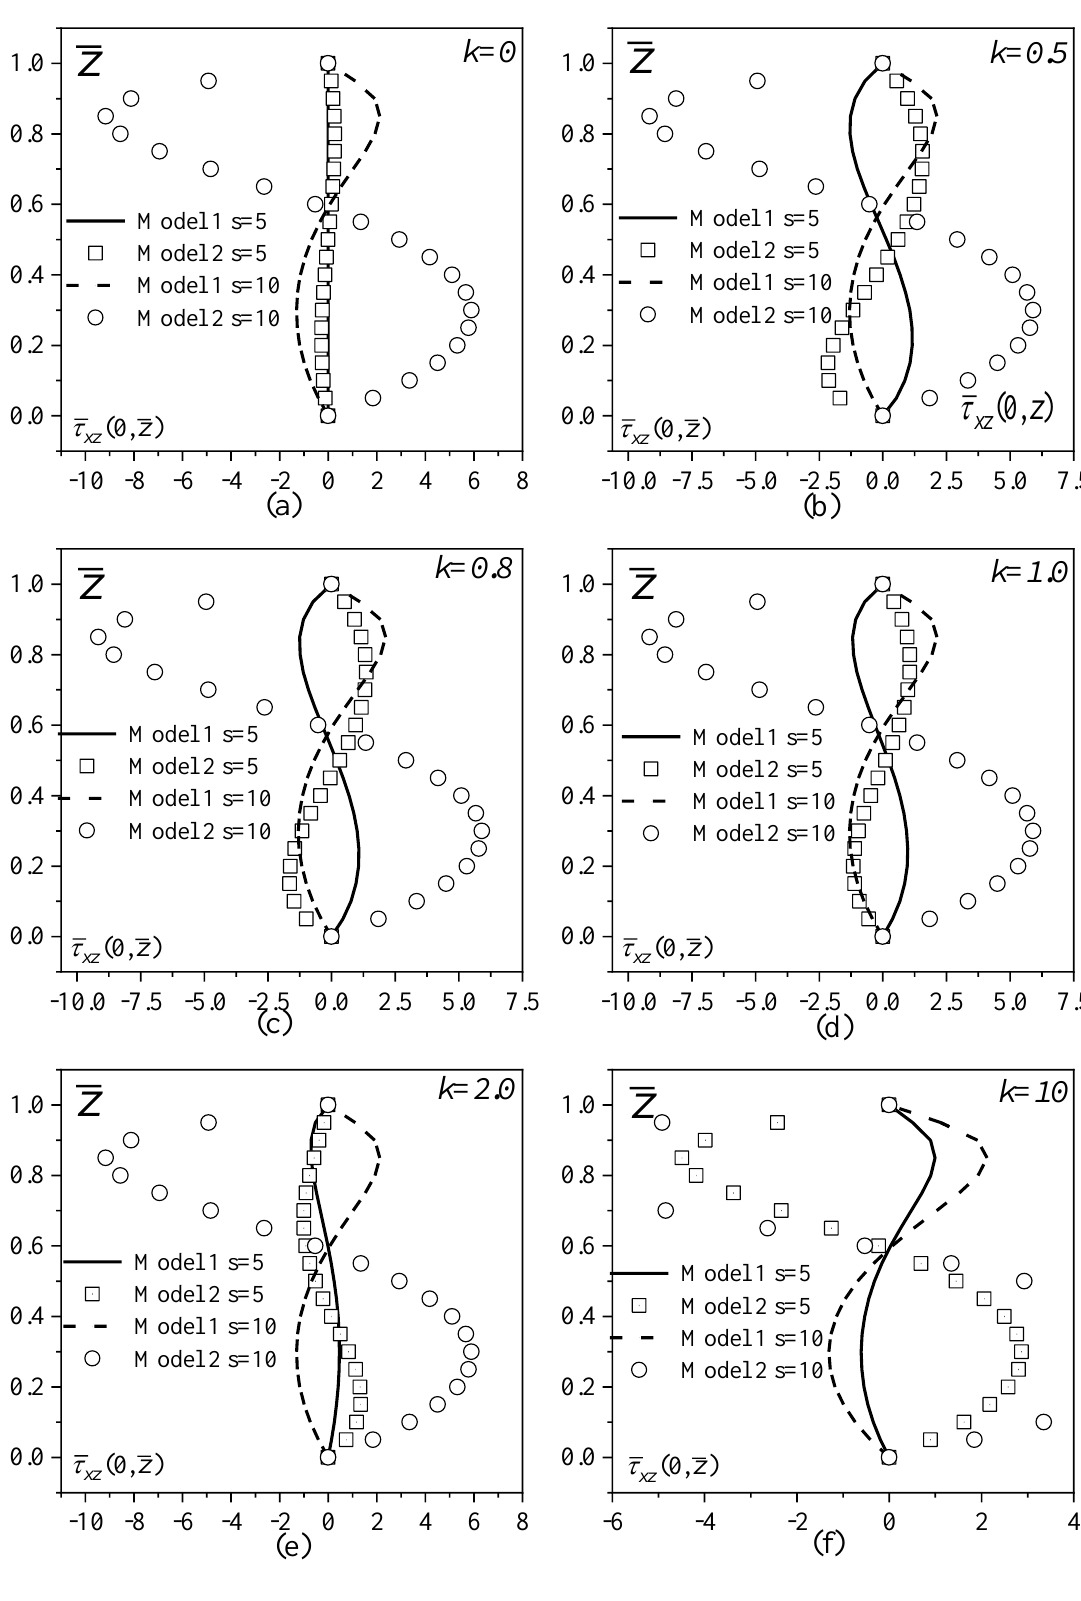
Fig. 8. Thickness variation of normalized transverse stresses ( xz  ) for various graded FG laminate [Material set